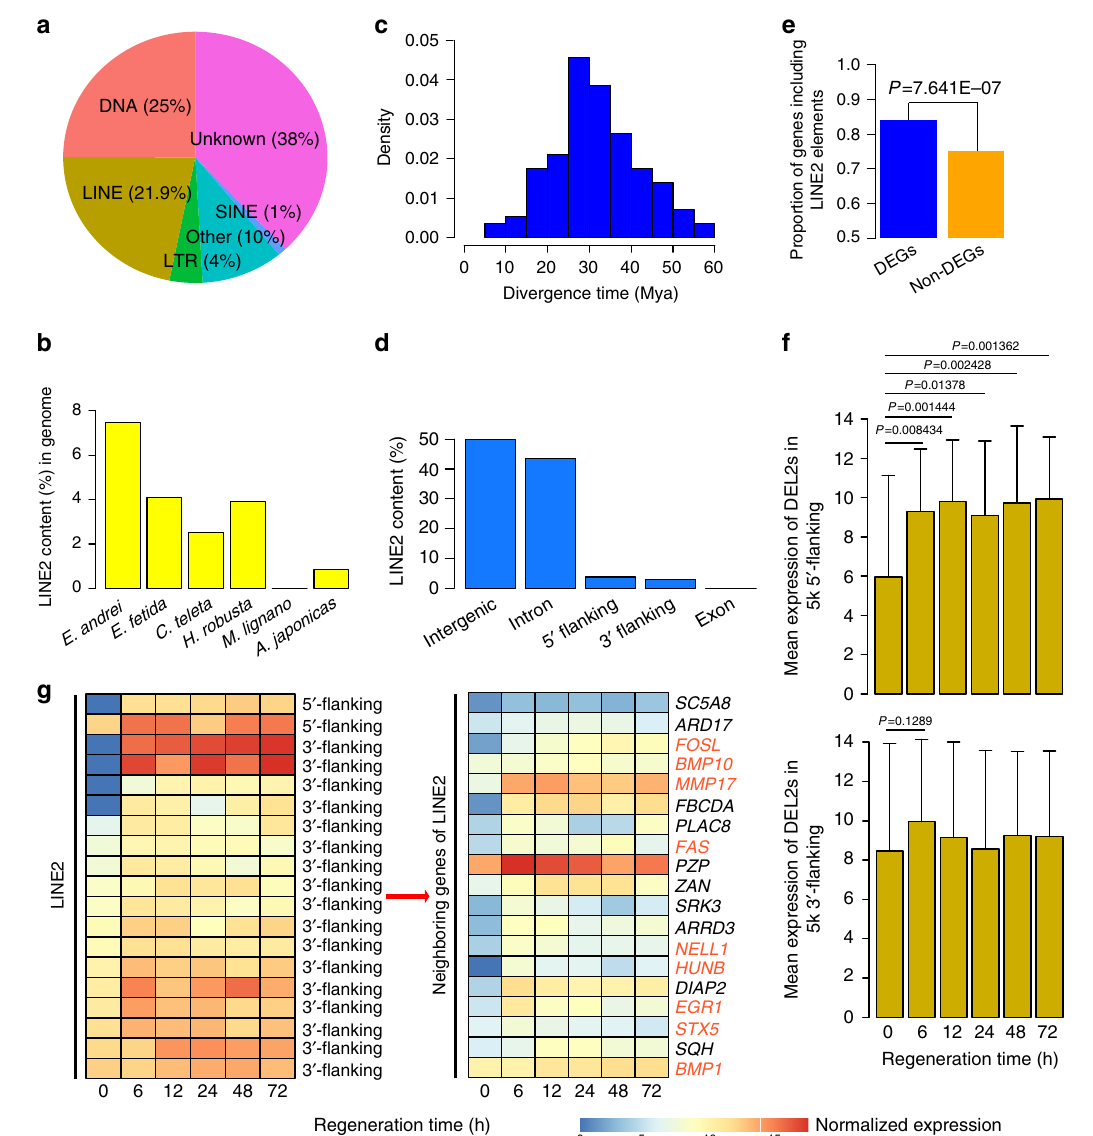
Fig. 3 LINE2 transposable elements are related to regeneration in earthworm. a Pie of the major repeat classes in earthworm genome. LINE: long interspersed nuclear elements; SINE: short interspersed nuclear elements. b Comparative analyses of LINE2 contents in the genomes across different invertebrates. c Divergence time of LINE2 in the earthworm genome. Kimura nucleotide distance of masked regions against their consensus sequences are automatically estimated by RepeatMasker, and the L2 element age was calculated using a mutation rate of 2.7 × 10 − 9 (in C. elegans ). d Distribution trends of LINE2 in the earthworm genome. e Proportion of DEGs harboring LINE2 (5065/6048) signi fi cantly surpassed the proportion of non-DEGs harboring LINE2 (19,421/25,769) ( P = 7.641E-07, Χ 2 test with Yates ’ continuity correction) during regenerative process in earthworm. f Mean expression values of 44 DEL2s ( n = 44) in 5k 5 ’ fl anking of coding genes and 119 DEL2s ( n = 119) in 5k 3 ’ fl anking of coding genes during regeneration process. Expression value of each DEL2 was normalized by Log 2 (expression + 1) for each time point after post-amputation. The signi fi cant levels were calculated by Mann-Whitney U- test with continuity correction. The error bars were calculated by using standard deviation (s.d.). g Similar expression pro fi le patterns between signi fi cantly differentially expressed LINE2 located in 5-kb fl anking regions of coding genes and their corresponding neighboring genes showing signi fi cant expression changes during regeneration in earthworm. Dark orange represented higher expression levels, and dark blue represented lower expression levels. The representative genes assocaited with regeneration were